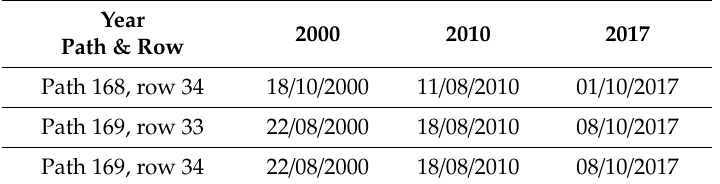
Table 1. Characteristics of the images used.